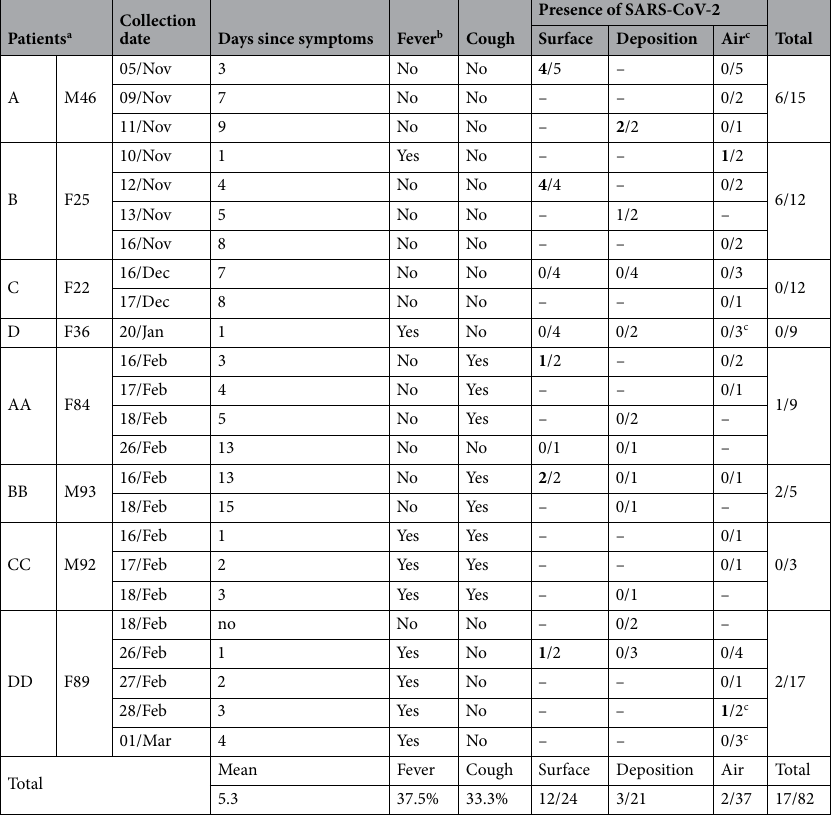
Table 2. Summary of samples, patients’ characterization and collection method. Significant values are given in bold. a Gender (male—M or female—F) and age of each patient are indicated. b Patient body temperature above 38 °C. c Air samples used for viability assays.